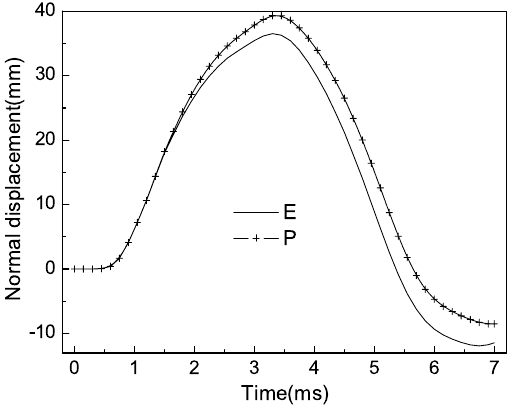
Fig. 17. Time history of normal displacement at the center on inner surface for different material models of windshield. (5) When bird velocity is relatively less, calculation results are almost the same by simulating bird as Lagrange and ALE elements,